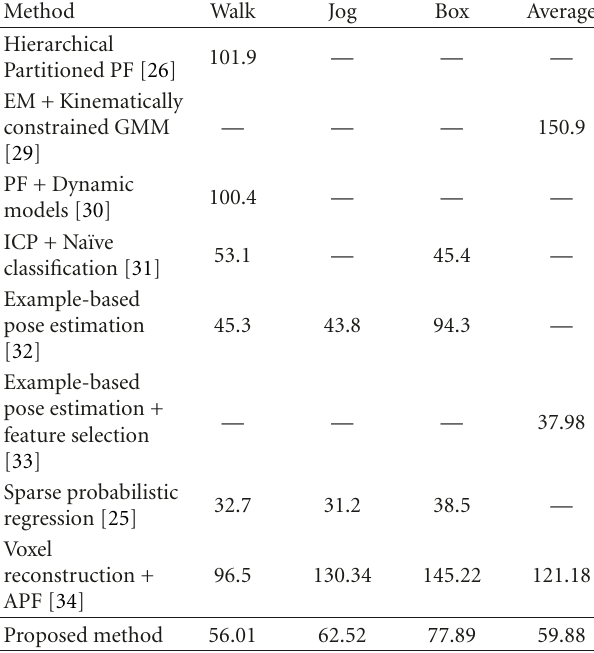
Table 1: Result comparisons with state-of-the art methods evalu- ated over the HumanEva dataset. The presented score corresponds to the mean of the error estimation μ , as reported by the compared authors in their respective